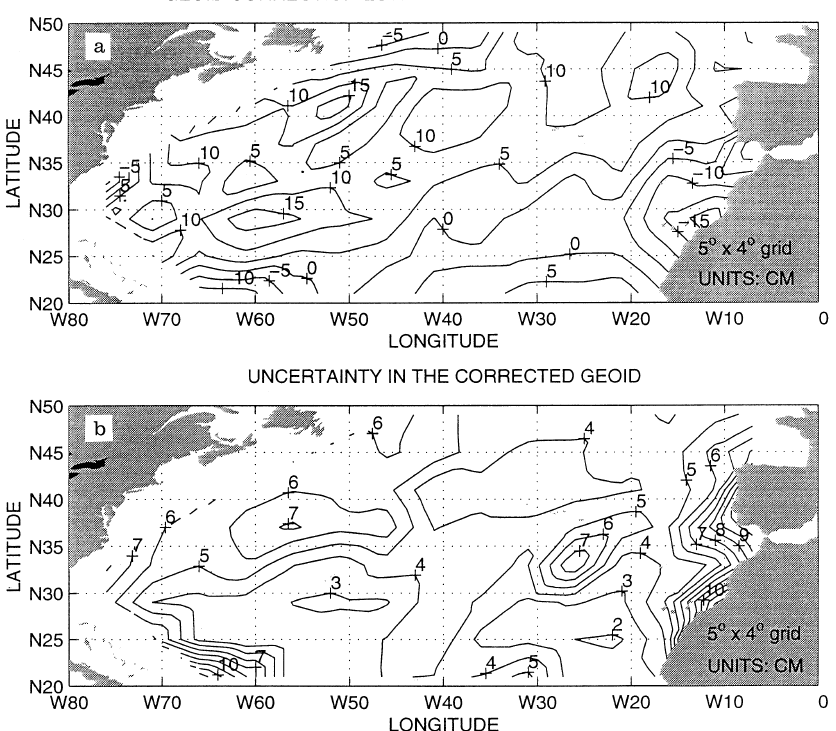
Fig. 10. a Correction to the geoid height (cm) estimated on the 5 (cid:176) (cid:180) 4 (cid:176) grid by the inverse model (run 2). b Uncertainty (cm) in the 5 (cid:176) (cid:180) 4 (cid:176) corrected geoid